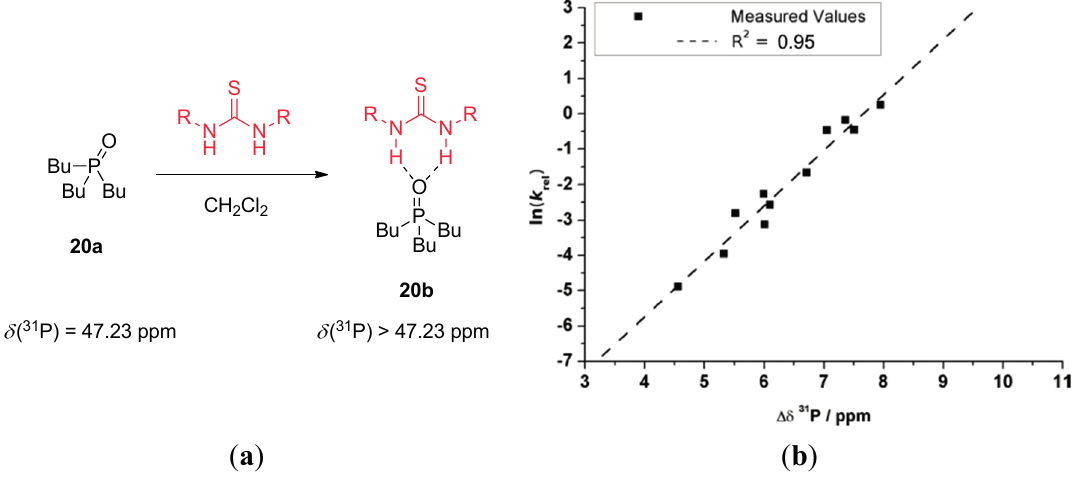
Figure 5. Quantification of H-bond strengths by 31 P-NMR shifts using 20a ( a ); the plot of ln( k rel ) values of Diels-Alder reaction of methyl vinyl ketone and cyclopentadiene vs. thiourea-induced 31 P-NMR shifts ( b ). Adapted with permission from Ref. [29]. Copyright (2014) John Wiley and